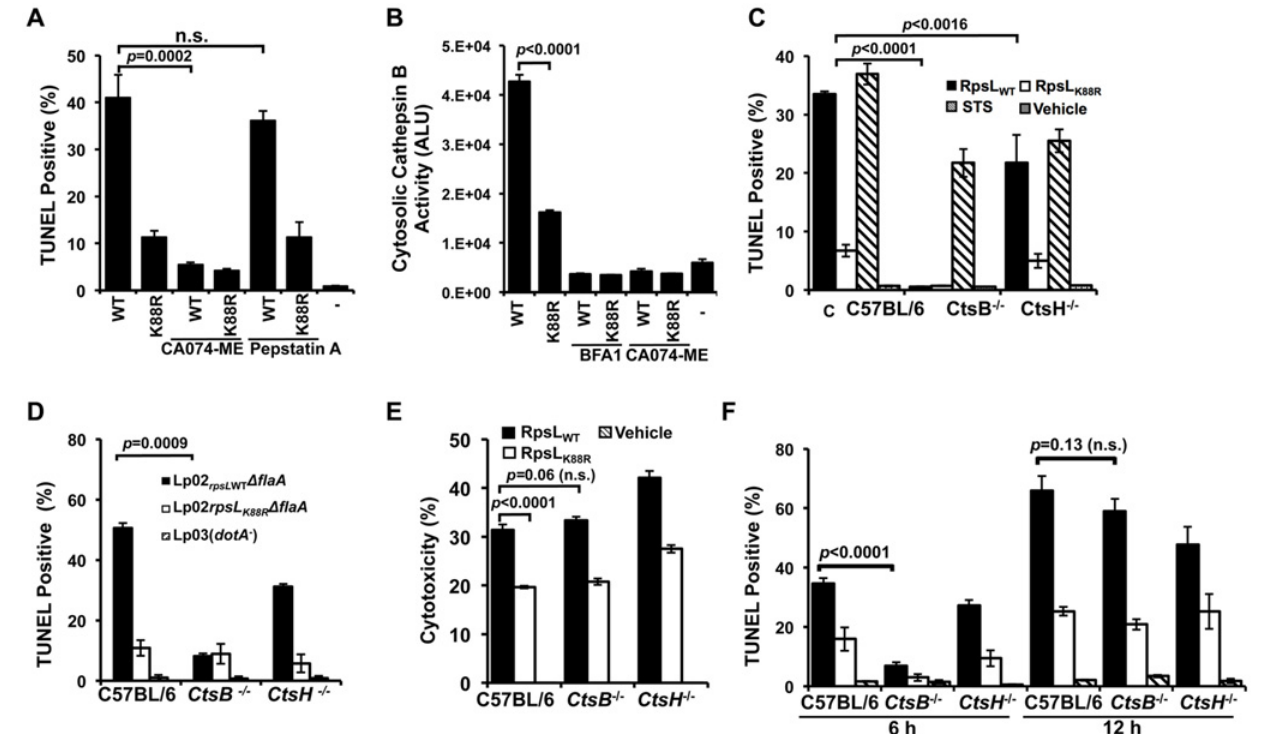
Fig 6. Cathepsin B is required for efficient RpsL-induced cell death in macrophages. A . Inhibition of CtsB activity alleviated RpsL-induced macrophage death. BMDMs from A/J mice were treated with 25- μ M CA-074ME (against CtsB), 25- μ M pepstatin A (against CtsD) or the solvent DMSO for 1.5 hrs before protein transfection. Cells were then processed for TUNEL staining. B . RpsL induced cytosolic release of cathepsin B. 1x10 5 BMDMs in 96-well plates were transfected with the proteins for 8 hrs, and the cytosolic cathepsin activity was determined with the substrate zRR-AMC by measuring free AMC with a TECAN plate reader. C . Cathepsin B is required for RpsL-induced cell death at 6 hrs post protein transfection. BMDMs prepared from ctsB -/- , ctsH -/- or C57B/ 6 mice were transfected with RpsL or RpsL K88R for 6 hrs, and the cell death was evaluated by TUNEL staining. Samples treated with staurosporine were established as positive controls. D . Cell death induced by L . pneumophila expressing wild type RpsL required CtsB. BMDMs from the indicated mice were infected with relevant bacterial strains for 12 hrs at an MOI of 5 and cell death status of infected cells was determined by TUNEL staining. In both C and D, each treatment was performed in triplicate and TUNEL signals were assessed from at least 500 cells from each sample. Similar results were obtained in three independent experiments. E . RpsL caused plasma membrane damage in BMDMs from ctsB -/- mice. Macrophages from indicated mouse lines